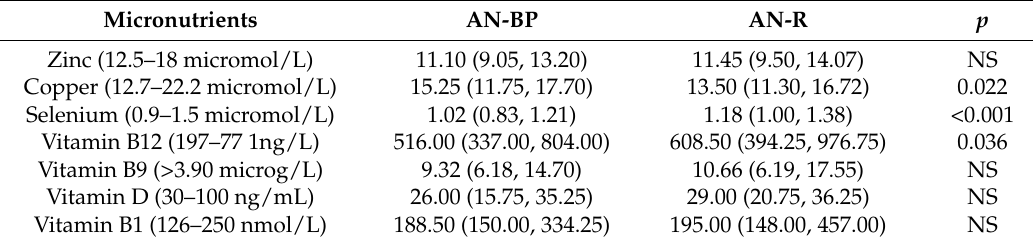
Table 3. Comparison of micronutrients status between AN-R and